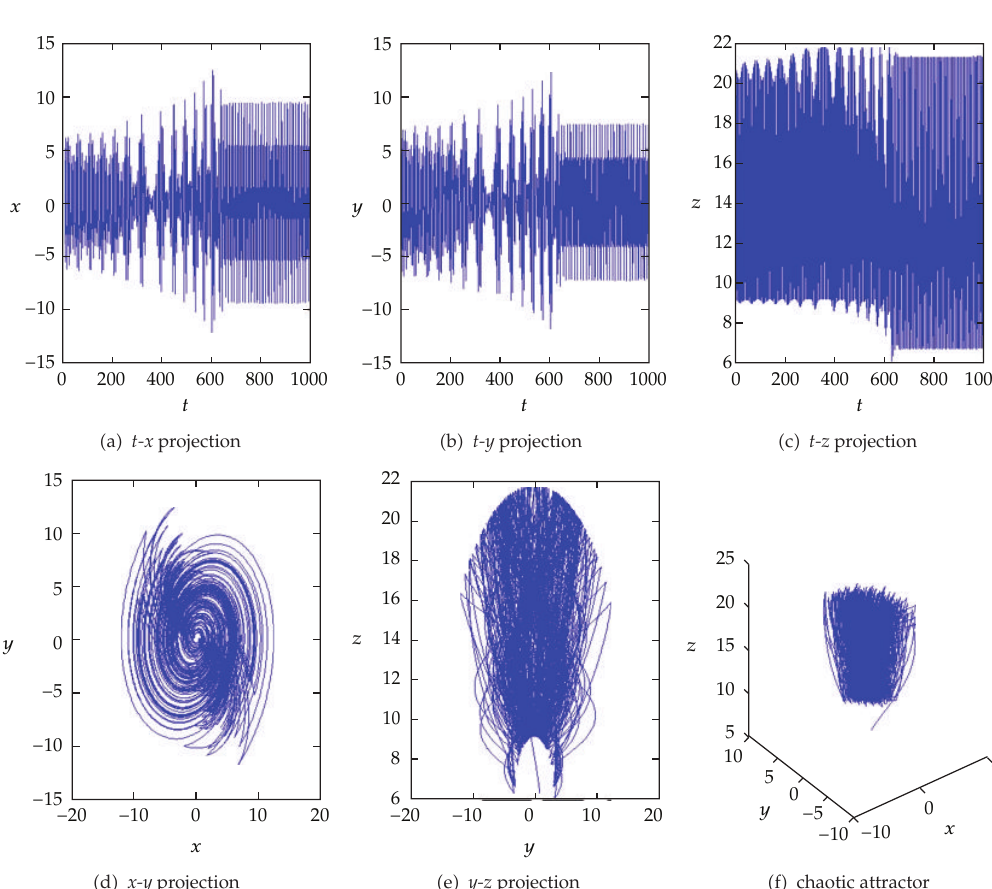
Figure 2: Chaotic attractor generated by two-dimensional space function (cid:4) 3.1 (cid:5) .